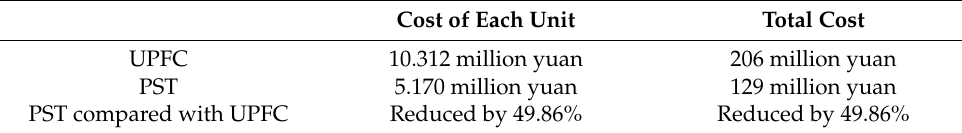
Table 3. Cost comparison between 220 kV PST and UPFC. Cost of Each Unit Total Cost 10.312 million yuan